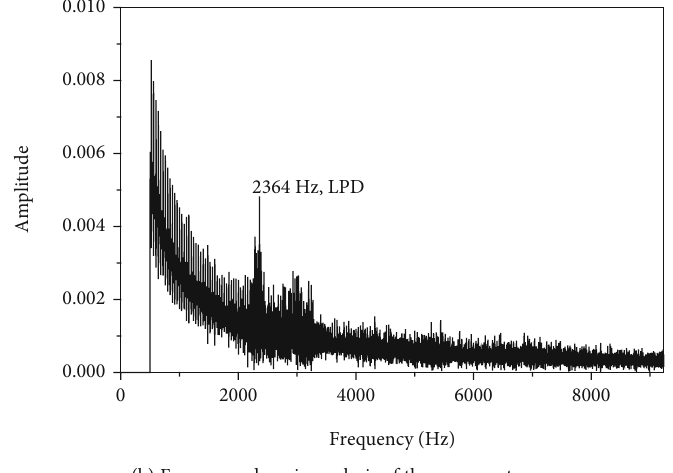
Figure 12: Continuous high-speed images and frequency domain analysis for LPD, 20000 fps, air fl ow 677g/s, and equivalence ratio 0.62